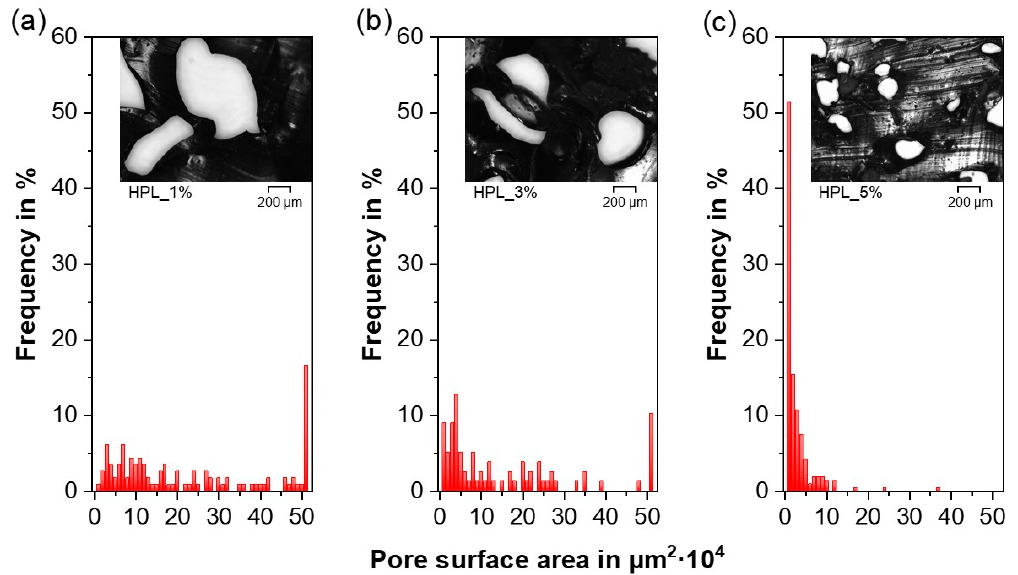
Figure 6. Pore surface area distribution and a representative cross-sectional micrograph for the formulations comprising hydrophilic thermoplastic polyurethane (HPL) and ( a ) 1%, ( b ) 3% and ( c ) 5% NaHCO 3 . Table 2. Average circle equivalent pore diameter (D a ) of the porous extrudates comprising hydrophobic (HPB), hydrophilic thermoplastic polyurethane (HPL) and NaHCO 3 as the pore former. Sample Designation